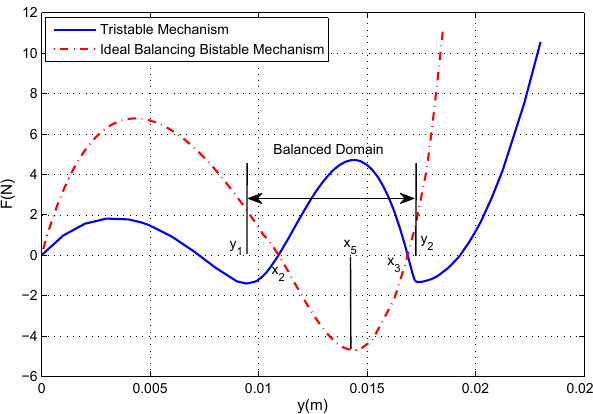
Figure 12. Force-displacement characteristics of the compliant tristable mechanism and a supposed ideal balancing bistable mech- anism.